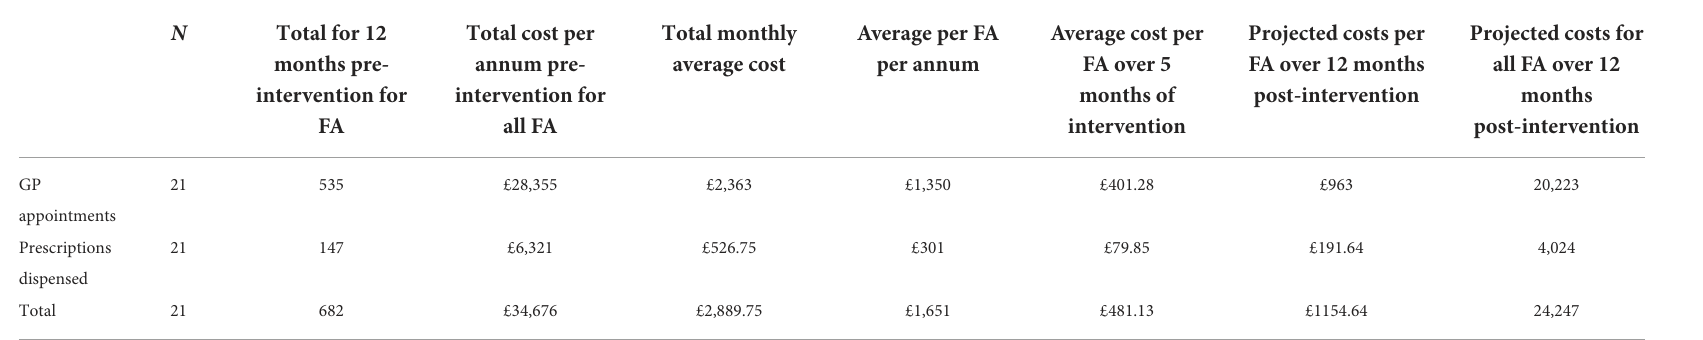
TABLE 4 Pre and post-intervention cost analysis for